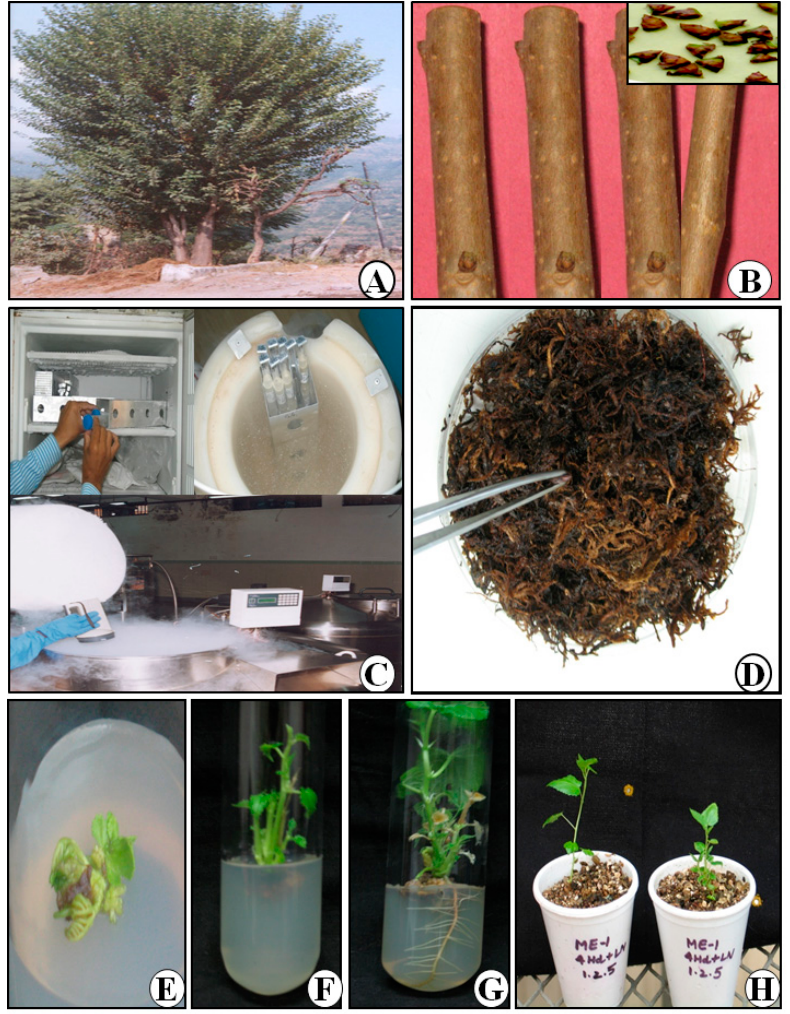
Figure 4. Recovery growth of mulberry from cryopreserved dormant buds after using different critical factors. ( A ) Mulberry tree in field genebank in winter period, ( B ) explants as a twig or dormant buds for cryopreservation, ( C ) freezing at different temperature and finally plunged in cryotank, ( D ) rehydration in sterile moist moss grass for different duration, ( E ) in vitro recovery of cryopreserved dormant buds of different Morus species, in vitro sprouting of dormant buds after cryostorage, ( F ) shoot multiplication and elongation, ( G ) rooting, ( H ) hardening of in vitro recov- ered plant. All photos were taken by the authors and all photos are original.